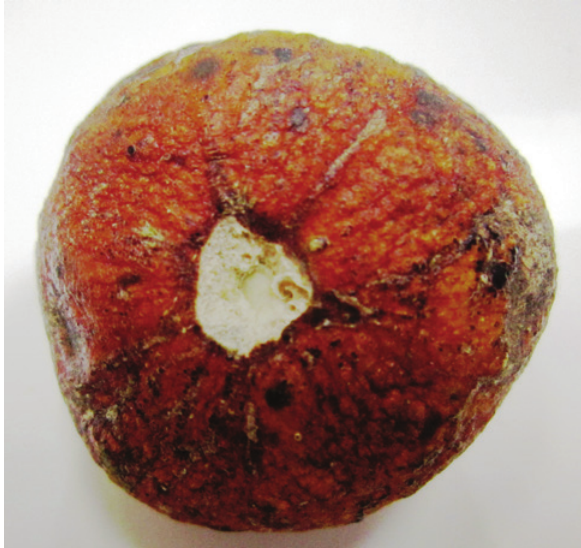
Figure 1: Andean Shora